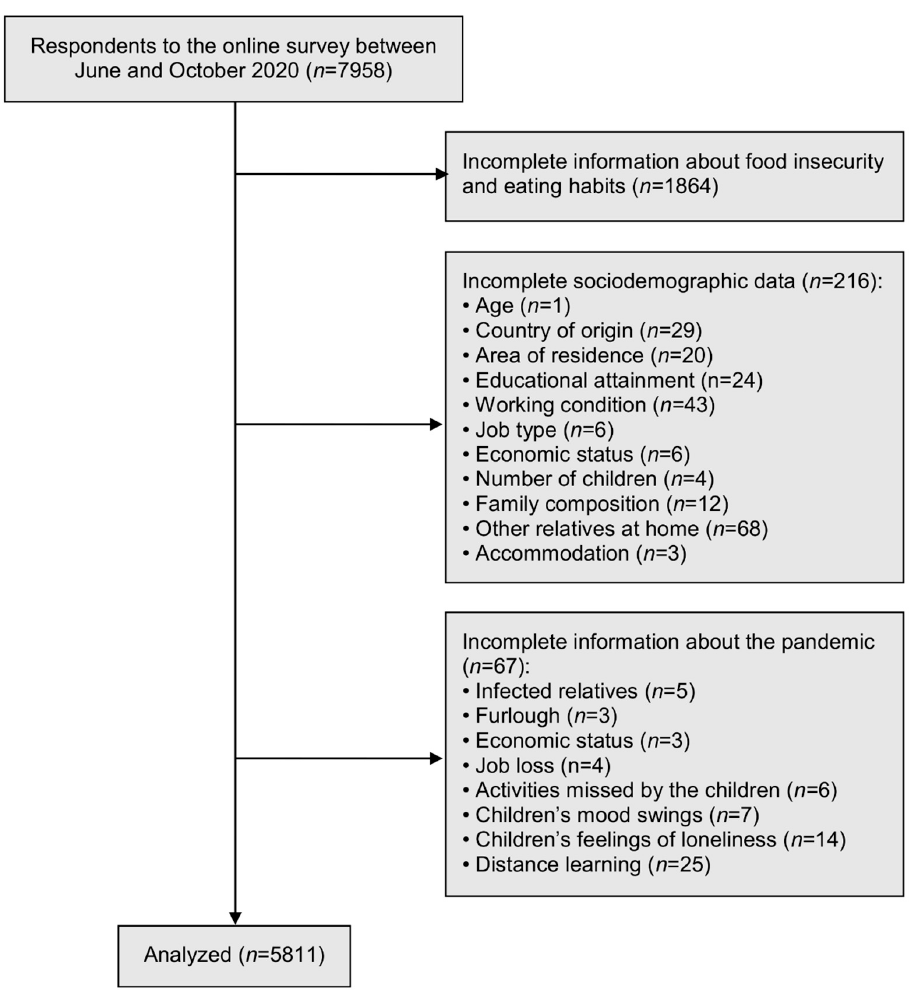
Figure A1. Diagram depicting selection of the study sample.